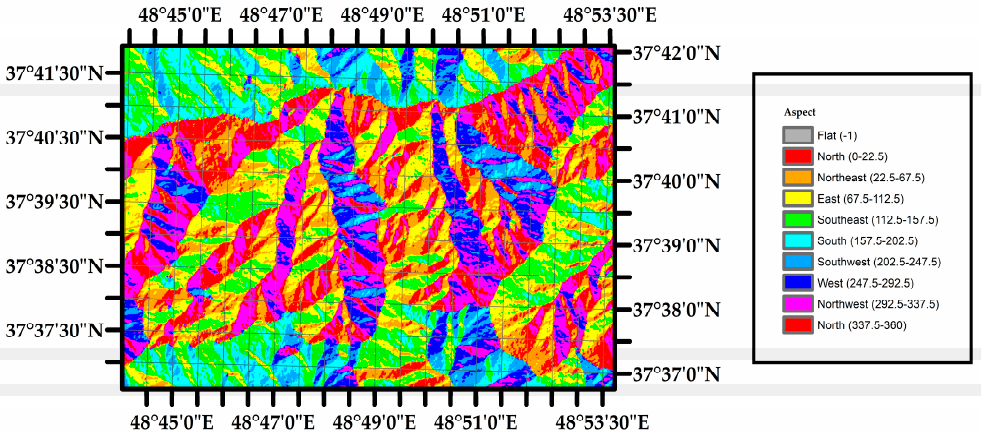
Figure 6. Aspect variation map in research area.